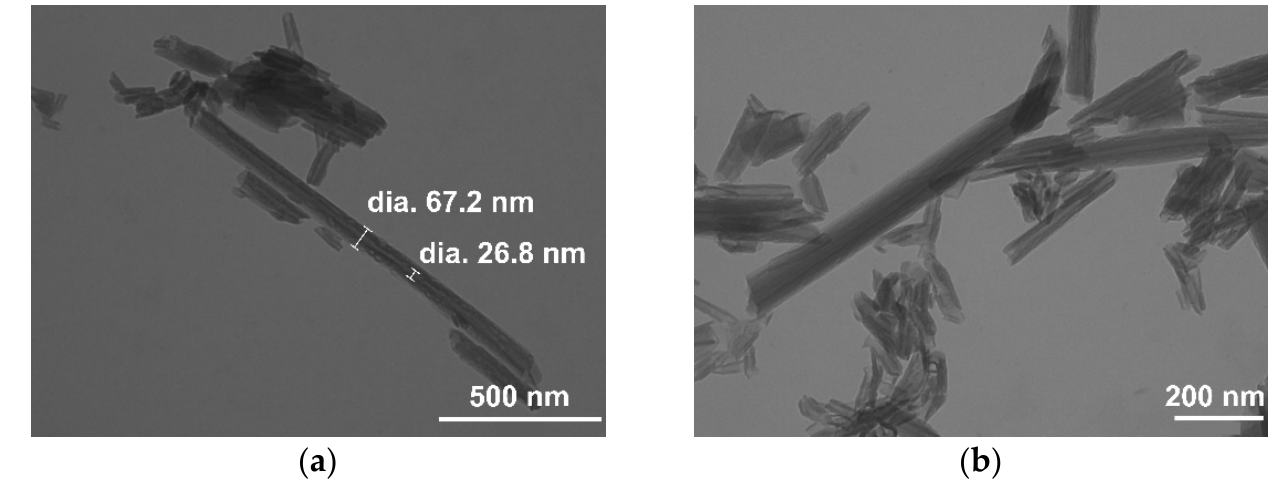
Figure 3. TEM images of the commercial halloysite sample at magnifications of ( a ) 75 kX and ( b ) 100